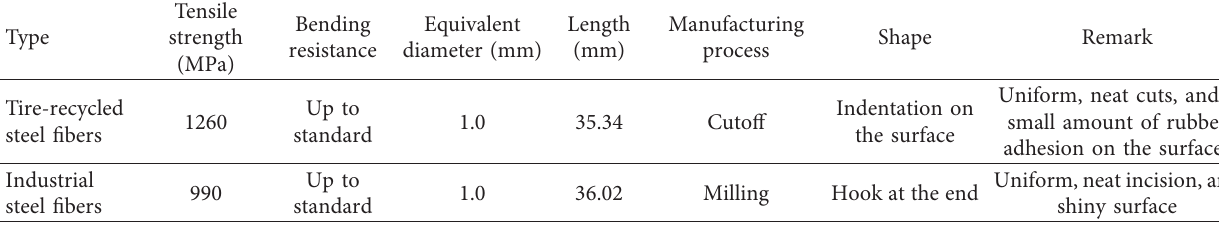
Table 1: Performance parameters of steel fibers.